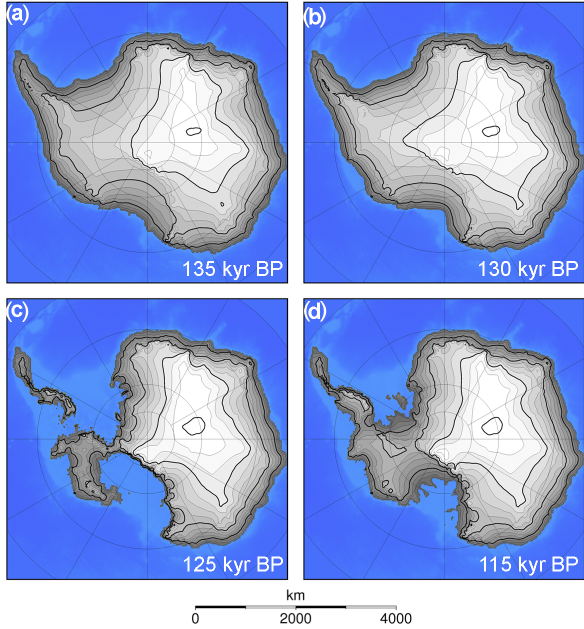
Figure 9. Antarctic grounded ice sheet geometry at 135kyrBP (a) , 130kyrBP (b) , for the minimum ice sheet volume at 125kyrBP with a sea-level contribution of 4.4m (c) , and at the end of the ref- erence experiment at 115kyrBP (d)